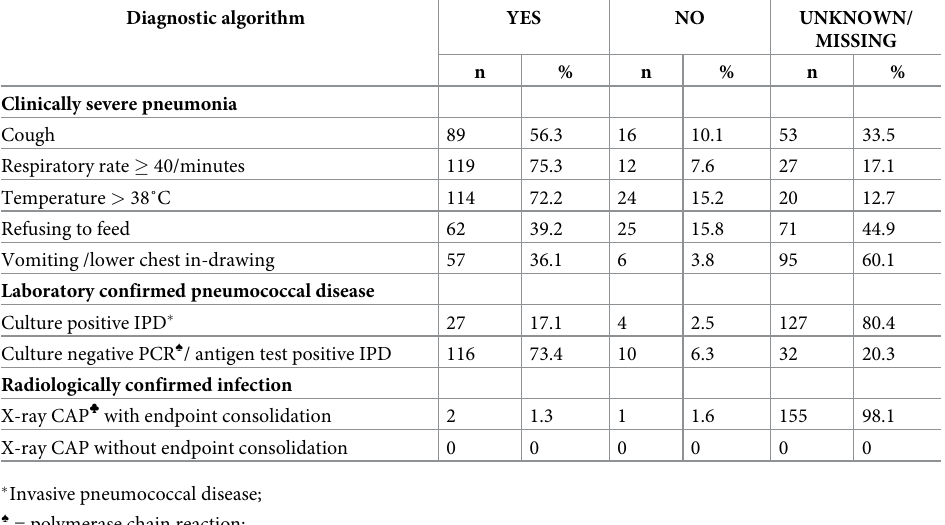
Table 3. Distribution of pneumococcal disease associated deaths by study case definition in children 1–59 months old in Yaounde´, between January 2006 to December 2012 (N = 158). Diagnostic